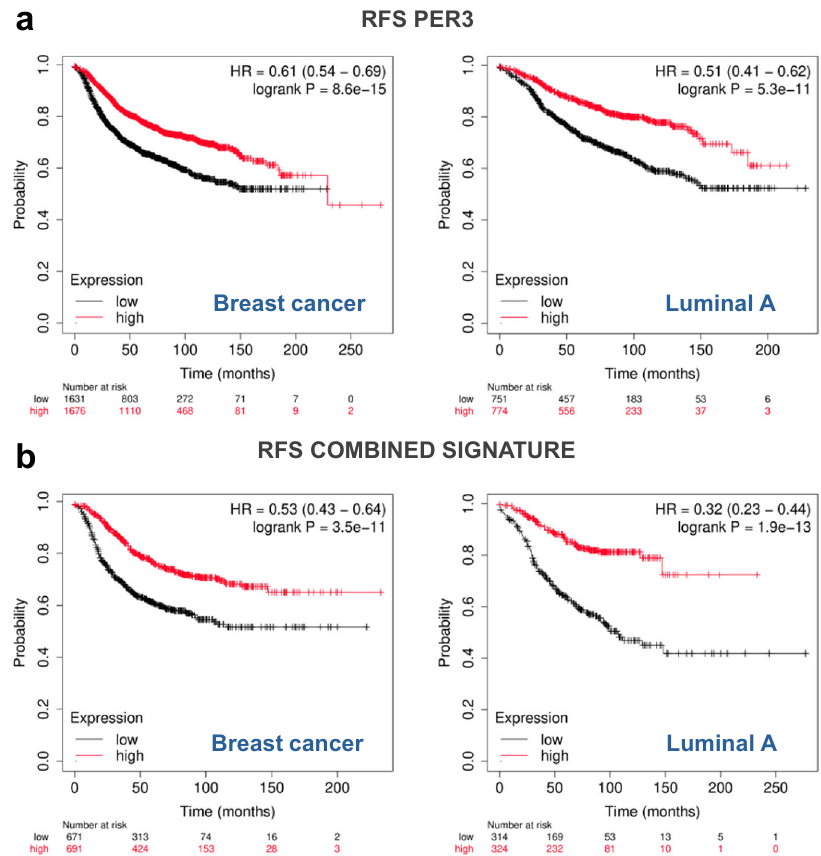
Fig. 6 Kaplan – Meier curves depicting RFS analyses results. a RFS analysis results based on PER3 expression levels using the complete breast cancer dataset (left panel) and the subset of samples classi fi ed as Luminal A (right panel). b RFS analysis results based on the average gene expression of genes signi fi cantly co-expressed with PER3 in human and murine healthy mammary tissues that were signi fi cantly associated with RFS in univariate analysis. The left panel shows the results for the complete breast cancer dataset whereas the right panel does it for the luminal A subset. Red lines represent samples showing high expression values ( fi rst tertile) of PER3 or the combined signature whereas black lines represent low expression values (third